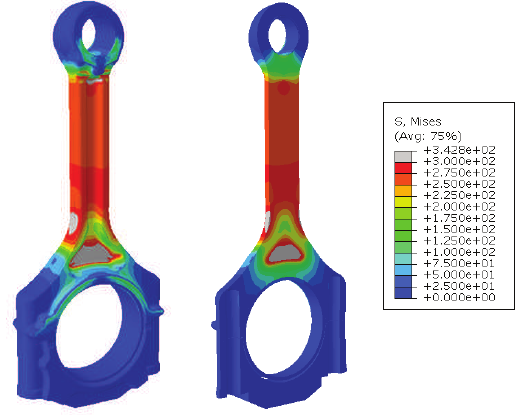
Fig. 6. Results of simulation of connecting rod model